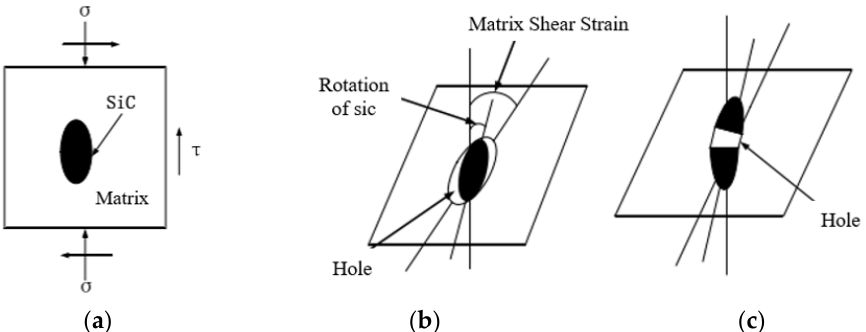
Figure 7. Schematic diagram of the removal method of SiC particles. ( a ) Force diagram of SiC; ( b ) low interface strength; ( c ) high interface strength.